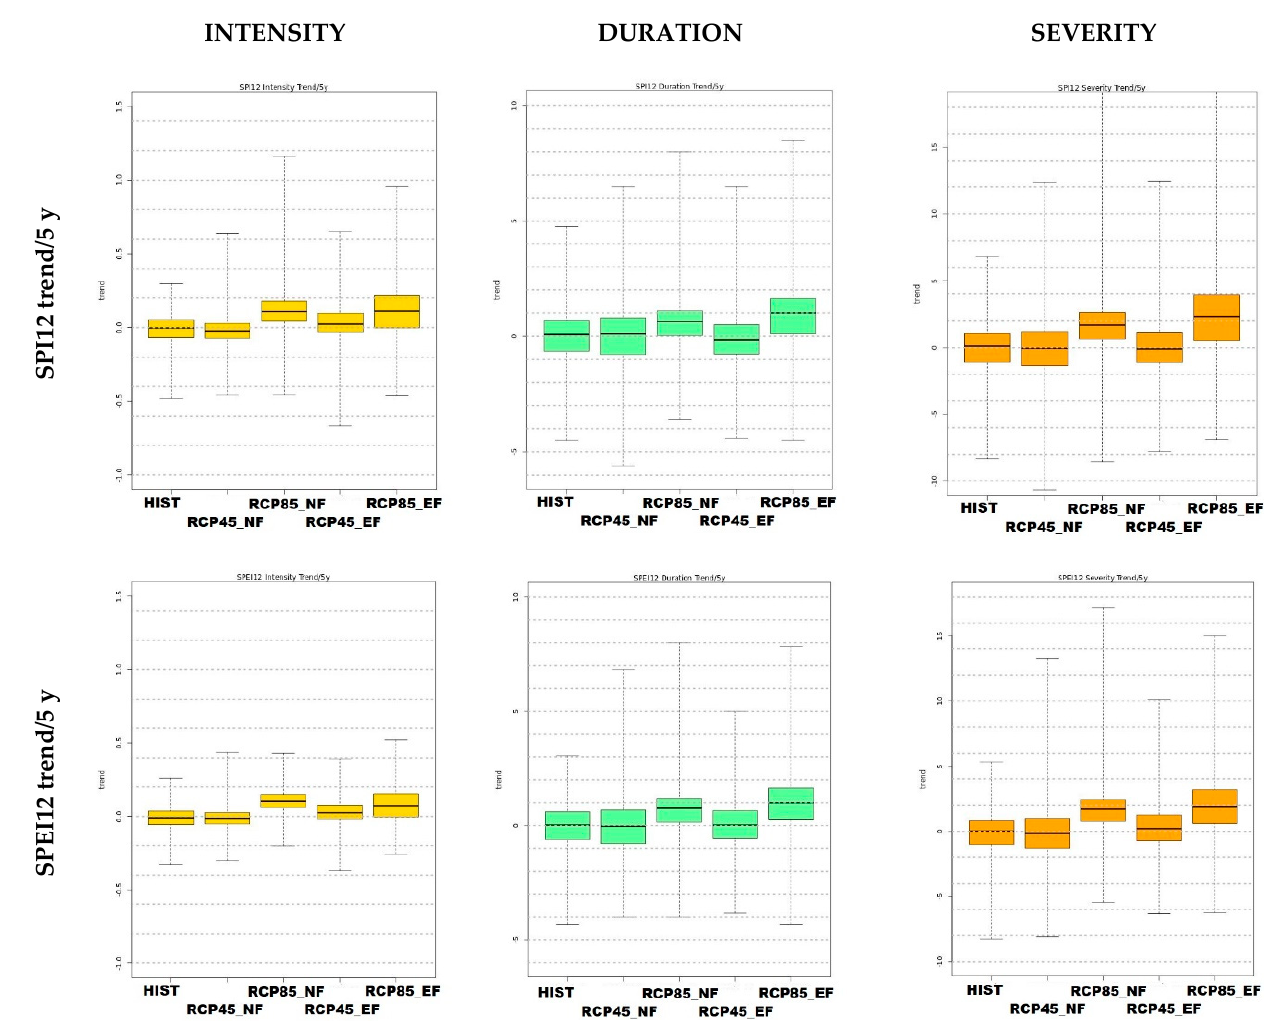
Figure 16. Five − year mean trends of drought severity, intensity and duration averaged over land area, for the 12 − month SPI/SPEI under RCP4.5 and RCP8.5 for the near period 2025–2049,